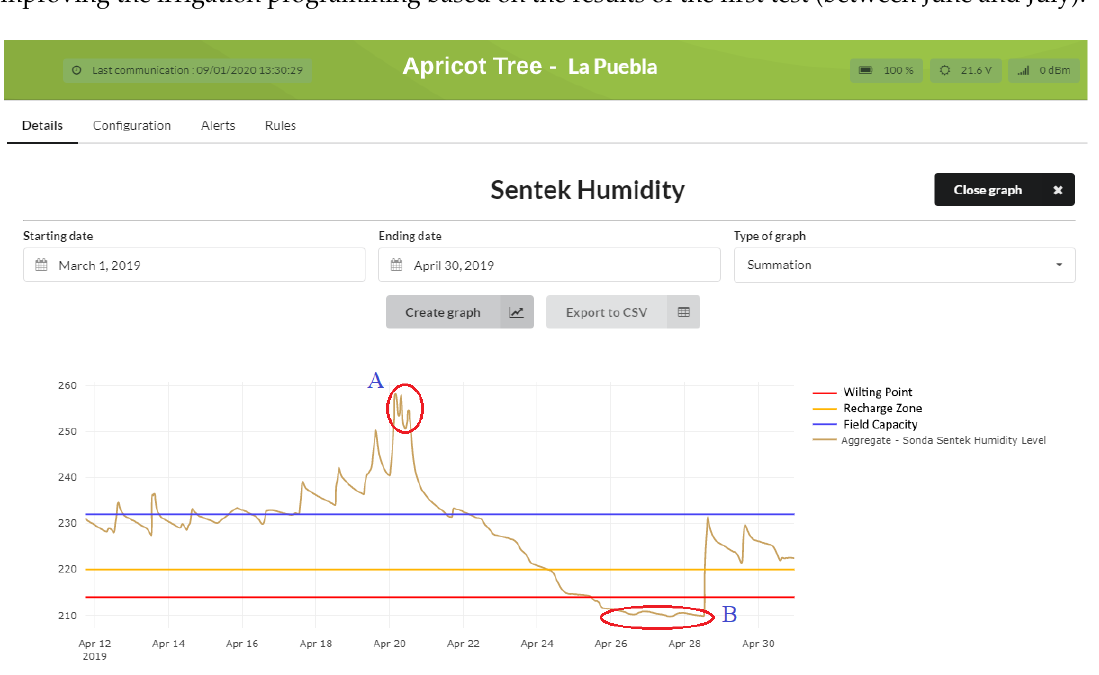
Figure 8. Evolution of the humidity of an apricot crop based on set water